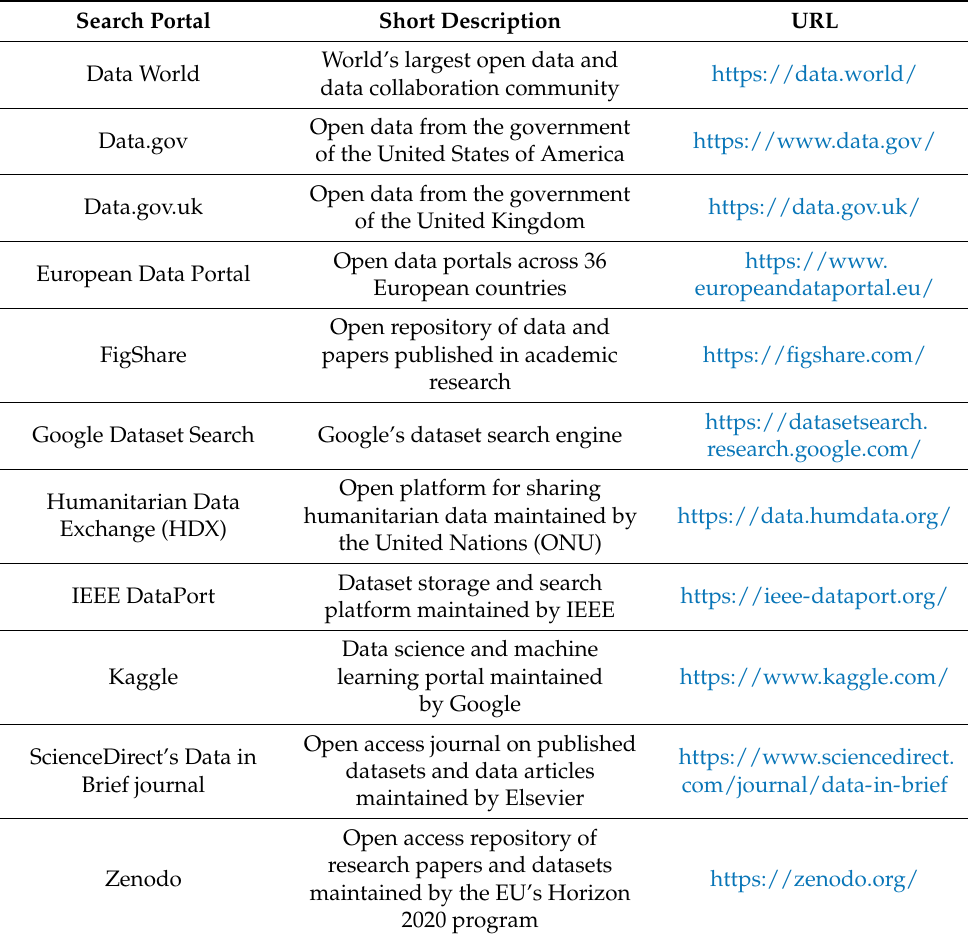
Table 1. A short description of all search databases. The databases were accessed on a regular basis between 15 February 2020 and 15 January